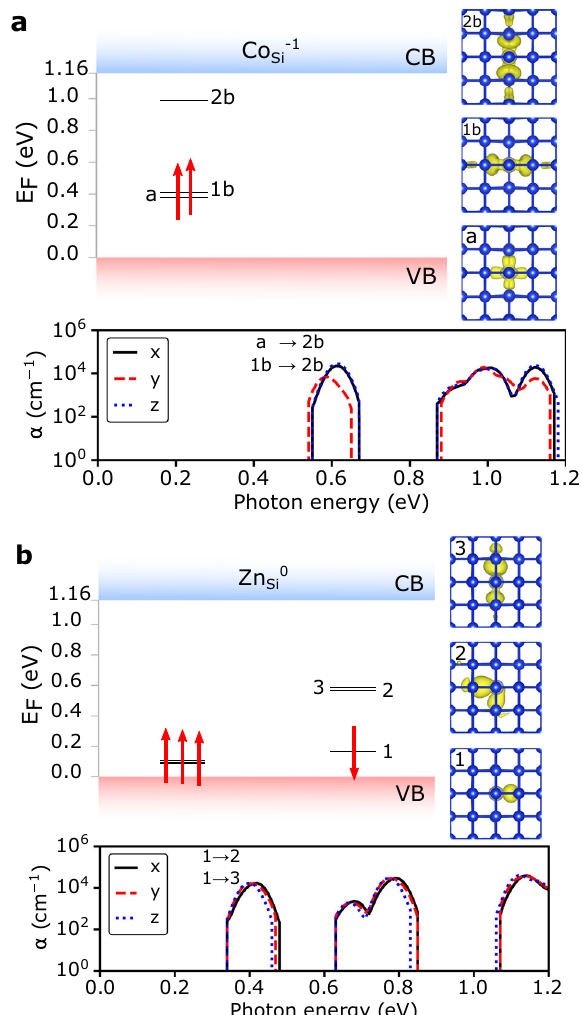
Fig. 3 Single-particle defect-level diagram and absorption spectra for representative substitutional defects of transition metals. (a) Co (cid:1) 1 has C 2 symmetry while ( b ) Zn 0 has no symmetry. The Si Si numbers are used to distinguish different defect states while letters highlight their symmetries. The isosurface plots of the charge density of corresponding defect states are shown at the density of 0.0025 1 . Absorption coef fi cient ( α ) are provided, with speci fi c peaks a 3 B indicated for the corresponding transitions between labeled defect states within the band gap. x, y, and z indicate the polarization ), direction. All the other substitutional defect candidates (Cu (cid:1) 1 Si which also have in-gap triplet – triplet optical transitions, can be found in the Supplementary Fig. 2.